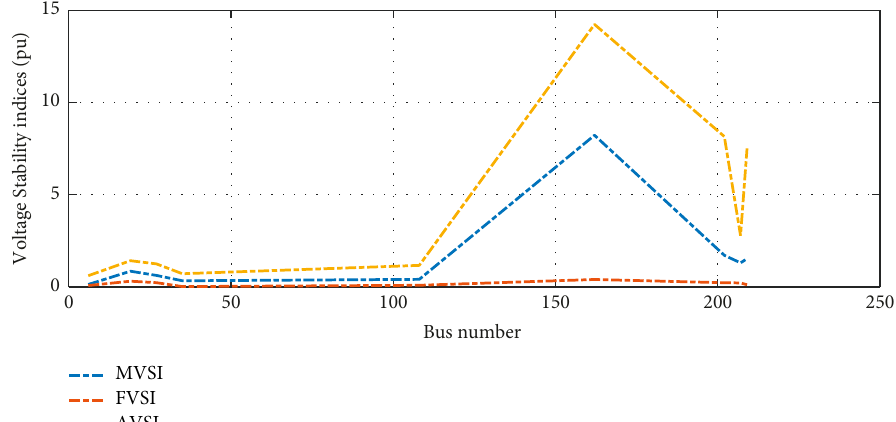
Figure 5: Voltage stability indices at base case.